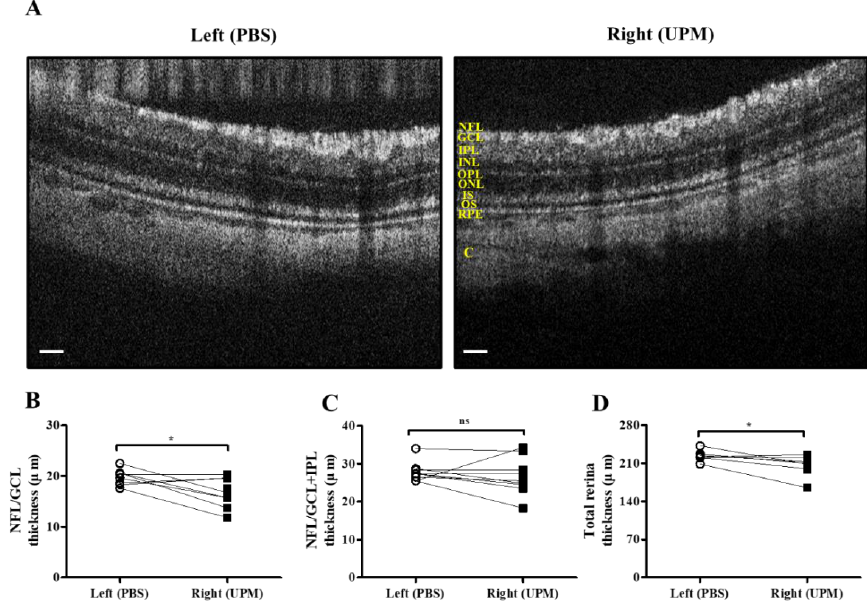
Figure 7. Retinal thickness analysis by SD-OCT at 16 weeks of UPM exposure. ( A ) Images of the retina acquired by SD-OCT are shown. Each layer is marked by yellow letters. The scale bars indicate 100 µ m. Direct comparisons between the left and right eye thickness of NFL / GCL ( B ), NFL / GCL + IPL ( C ) and the total layers ( D ) determined by SD-OCT software at 16 weeks are presented. * p < 0.05 vs. left eye. NFL, nerve fiber layer; GCL, ganglion cell layer; IPL, inner plexiform layer; INL, inner nuclear layer; OPL, outer plexiform layer, ONL, outer nuclear layer; IS, inner segment; OS, outer segment; RPE, retinal pigment epithelium; C, choroid. ns, not significant. Int. J. Mol. Sci. 2020 , 21 , 4976